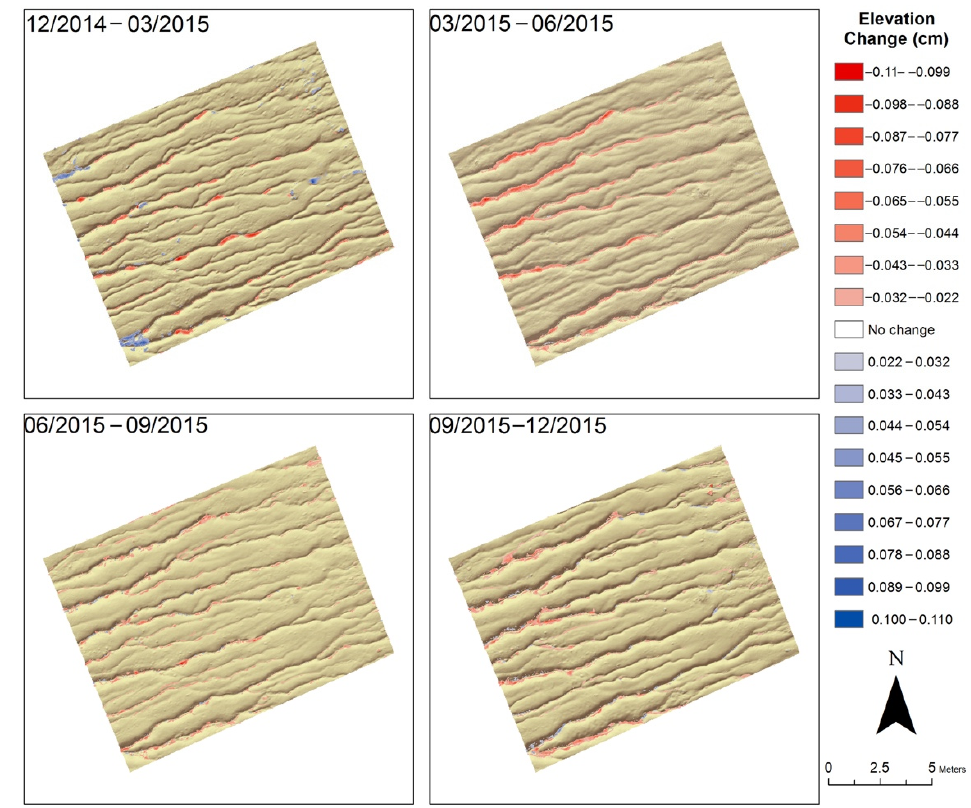
Figure 2. DoD results of the spatial pattern of erosion and deposition on the hillslope.